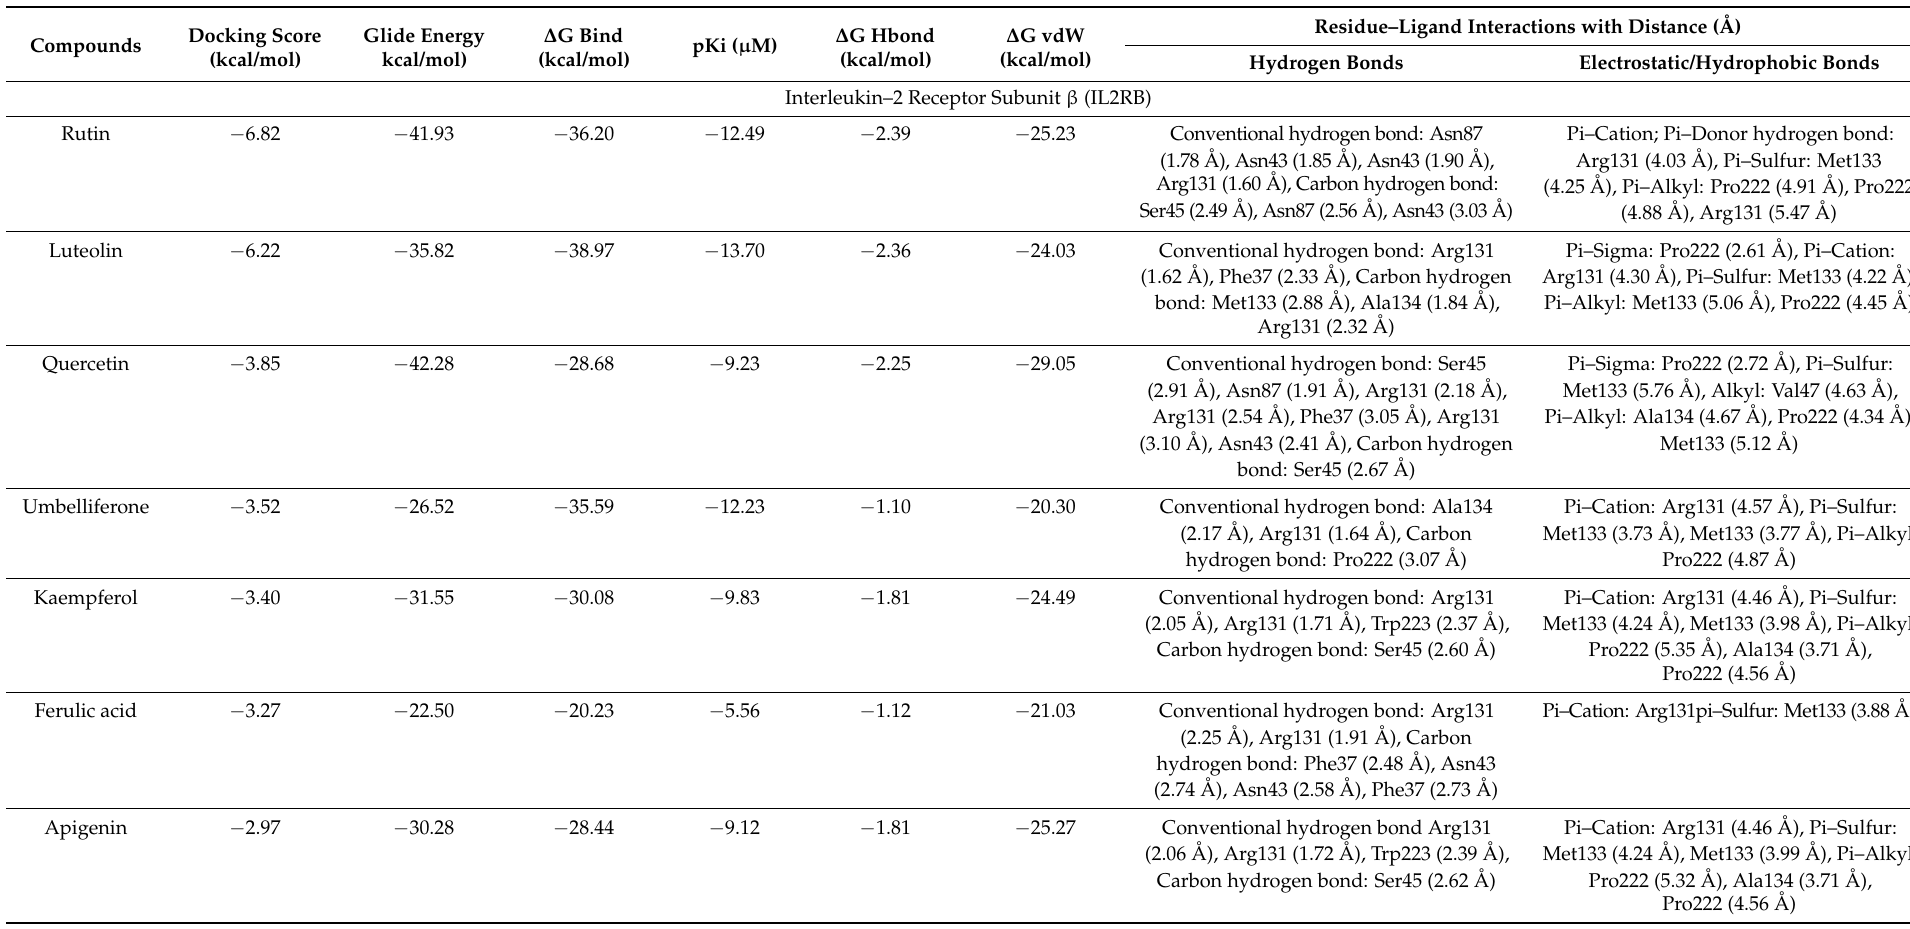
Table 4. The binding energies (kcal/mol) of docked ligand–protein complex calculated with Prime MM–GBSA.